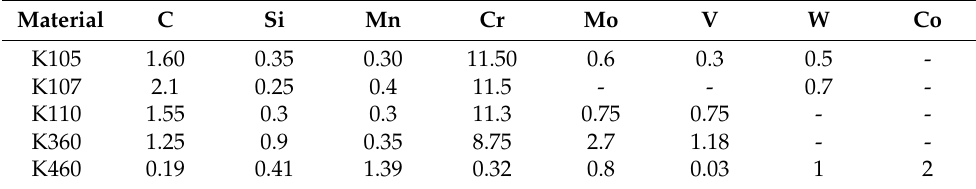
Table 3. The chemical composition of the steels used to make the trimming dies, %wt [20].